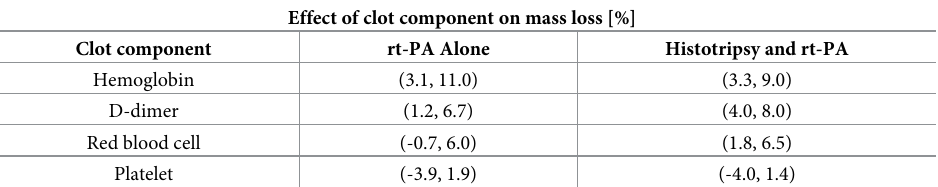
Table 1. The slope tabulated with multiple linear regression analysis between mass loss and clot components gen- erated due to exposure to rt-PA alone, or rt-PA and histotripsy.